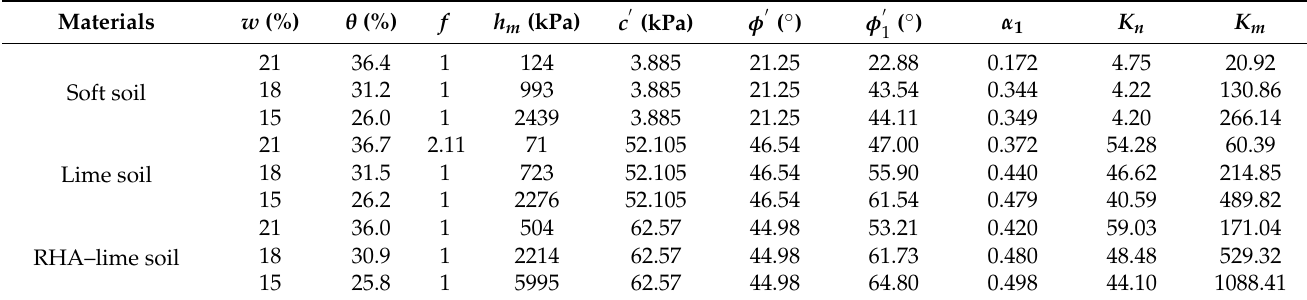
Table 4. Values of the parameters in the MEC model.